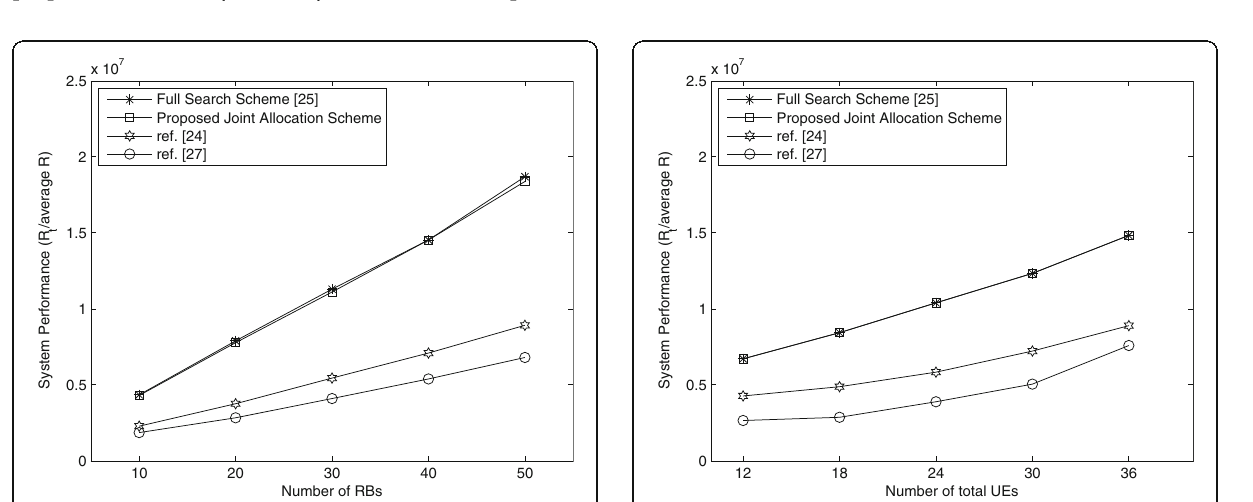
Fig. 7 Comparison of the proposed joint allocation scheme with the existing schemes. The value of the objective function versus the number of UEs with the number of RBs N = 50 and the bias value = 8